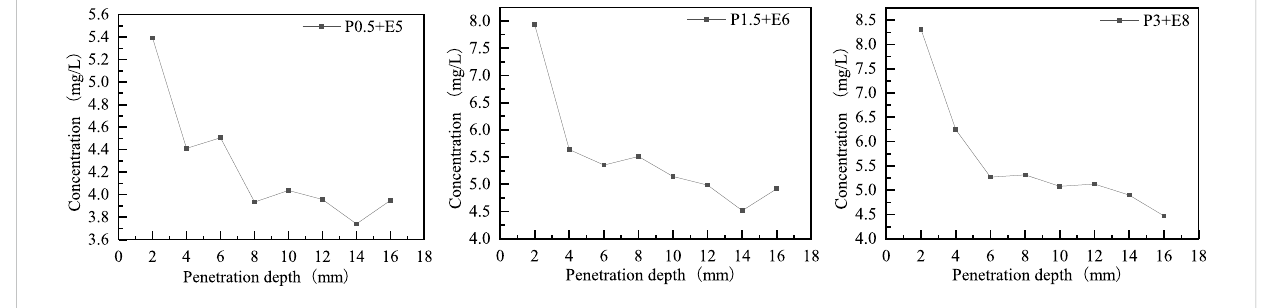
FIGURE 11 Other chelating agents promote the formation of ion chelators “ aggregation ” zones.